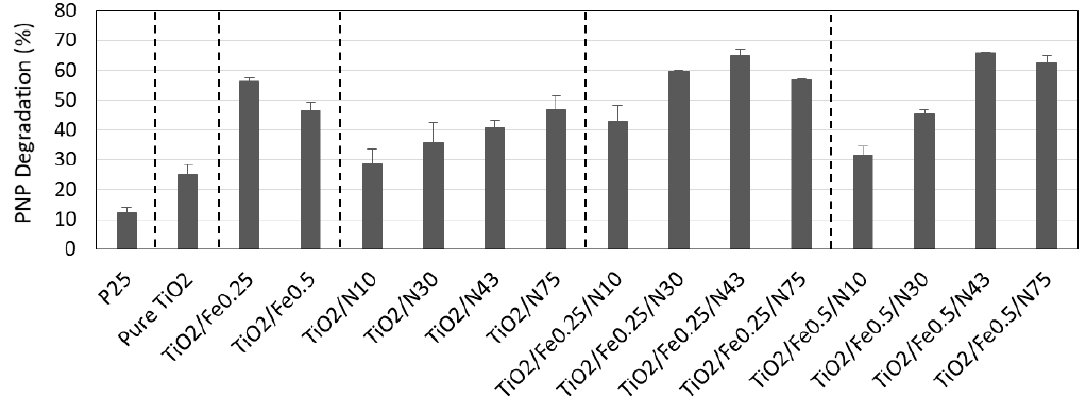
Figure 6. p -Nitrophenol (PNP) degradation (%) under visible light ( λ > 400 nm) for all samples after 24 h of reaction time.